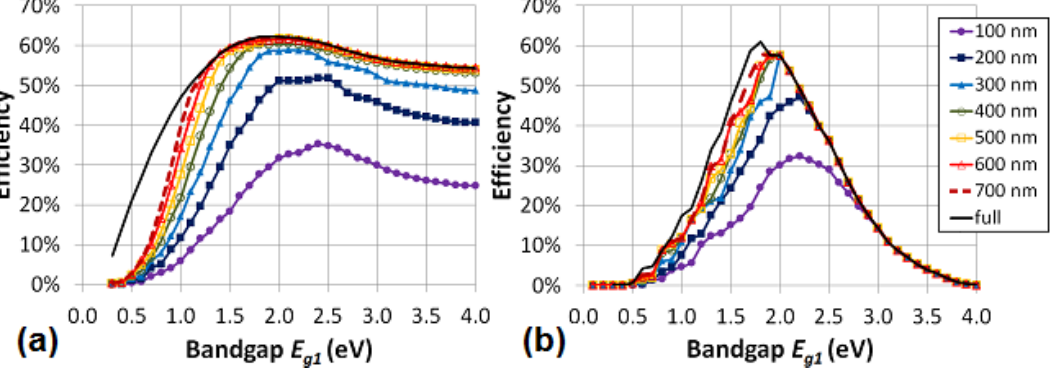
Figure 6. The maximum efficiency in the ideal scenario for a stacked ( a ) and a monolithic ( b ) organic triple-junction solar cell with varying bandgap E and E , and a LUMO difference of 0.2 eV between n - and p -type. The absorption E g2 g3 window varies from full absorption width to 100 nm absorption